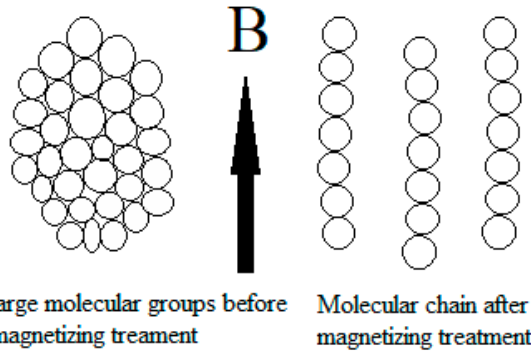
Figure 9. Under the magnetic field, the structure of molecular groups of nonpolar hydrocarbon oil (NHO) tends to be a molecular chain [35].